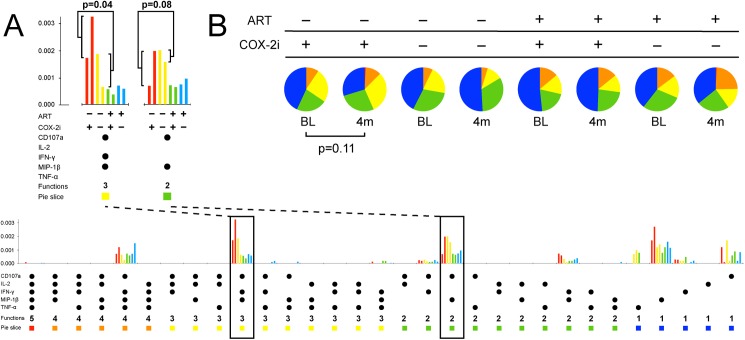
Polyfunctional responses of CD8+ T cells after stimulation with an HIV Gag peptide pool.A: Two prevalent polyfunctional subsets (CD107a+MIP1β+IFN-γ+ and CD107a+MIP1β+) increased after four months of etoricoxib in ART-naïve patients. ART and COX-2i use indicated, coloured bar pairs represent response at baseline and four months, respectively. B: The CD8+ T cell response tended to be more polyfunctional after four months of etoricoxib in ART-naïve patients (2 leftmost pies). P-values derived from unpaired permutation tests.